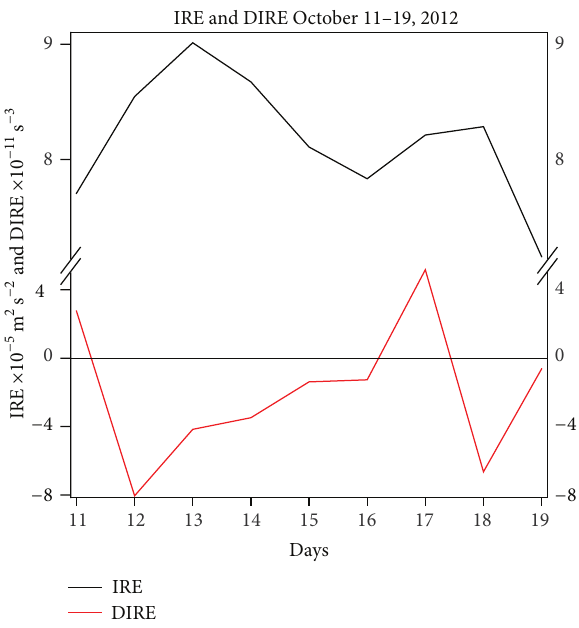
Figure 4: IRE and DIRE from ERA-Interim reanalysis for October 11–19, 2012.